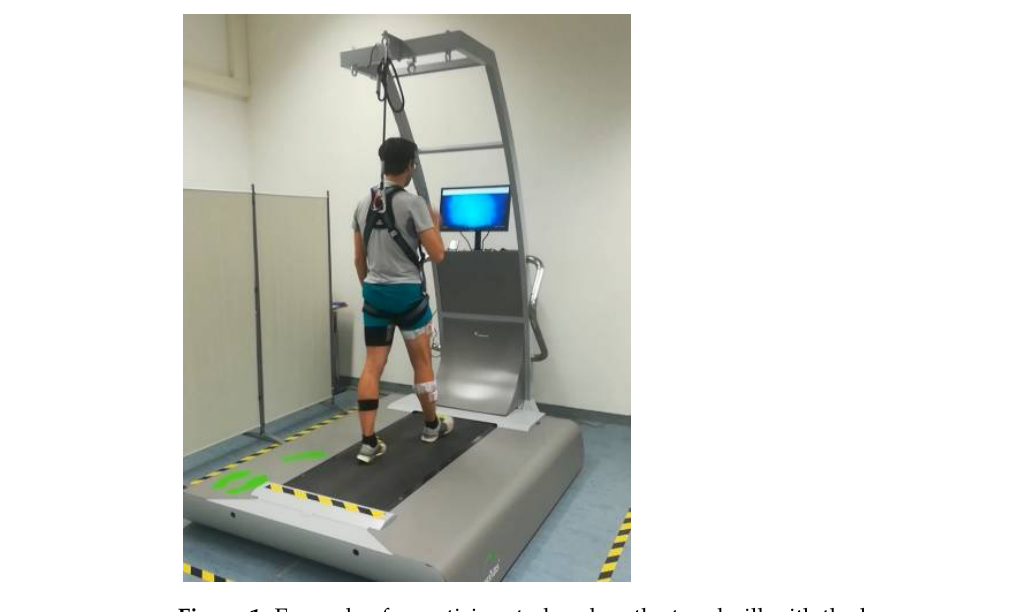
Figure 1. Example of a participant placed on the treadmill with the harness worn and the sensors positioned on the body segments of interest. The sensor on the pelvis was placed under the t-shirt.